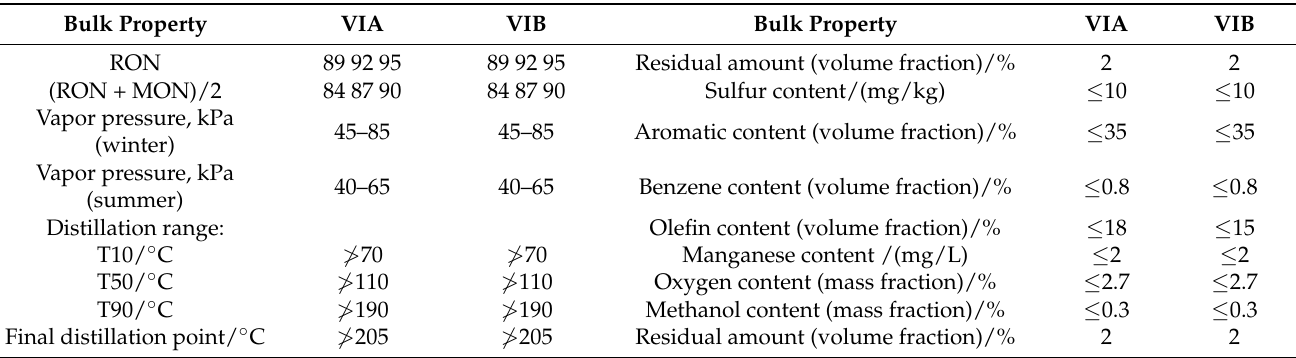
Table 1. The China motor gasoline VI